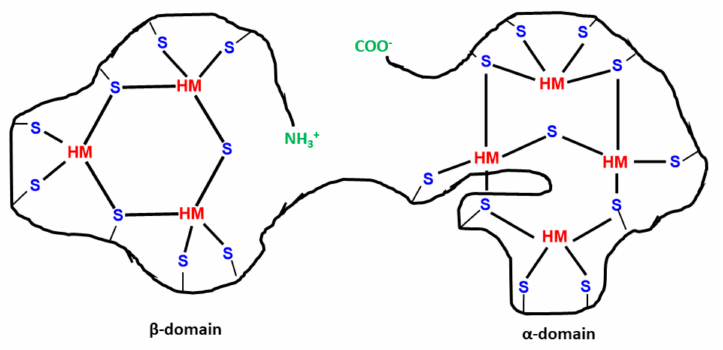
Figure 5. Domain nature of metallothionein (adapted from